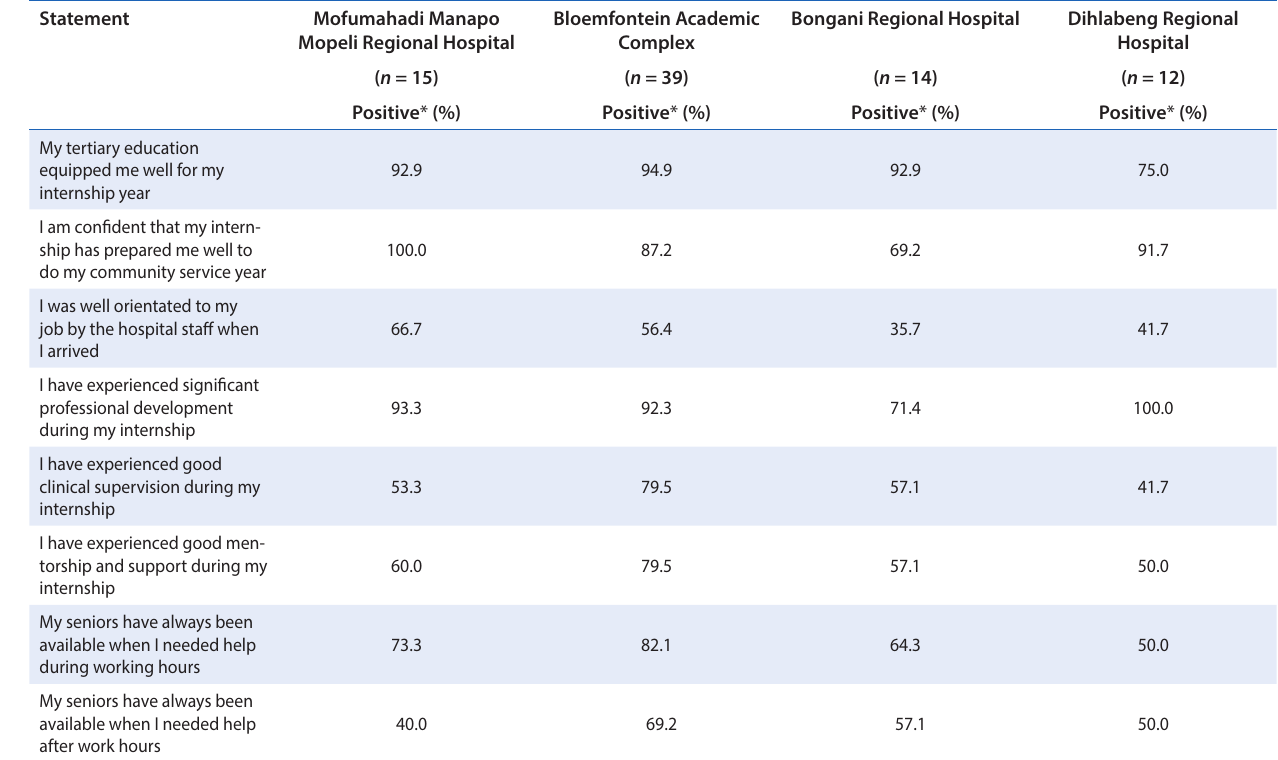
*Positive = strongly agree and agree.